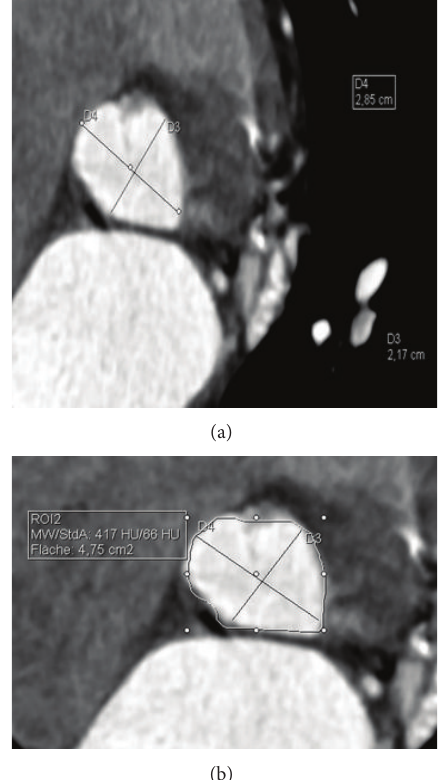
Figure 7: Aortic annulus sizing by CT. (a): The anterior-posterior (AP) (D3) and mediolateral diameter (ML) (D4) are measured on cross-sectional images. The mean of both diameters is commonly calculated for selecting the appropriate size of the transcatheter aor- tic valve prosthesis device finally used for TAVI (currently, 23 mm, 26 mm, or 29mm devices). Exact fit is crucial to avoid paravalvular leakage and to ensure seamless adaption of the prosthesis with the aortic annulus. (b): Quantification of the annulus area is another valuable parameter for selection of the final valve size. Aortic annulus area is traced with a digital caliper (Area, 475 mm 2